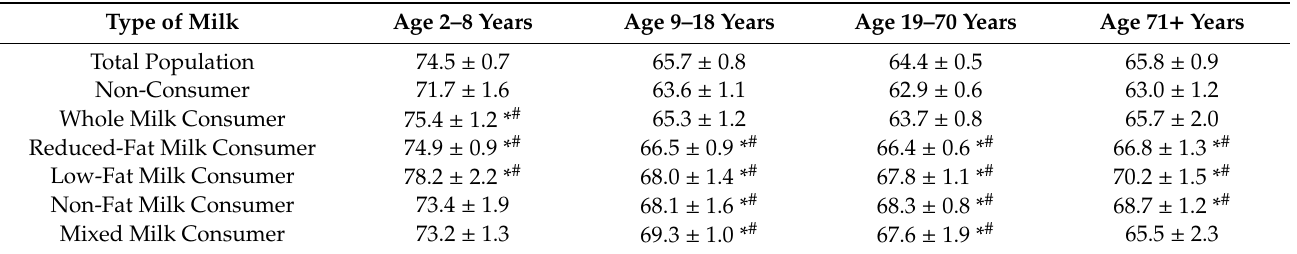
Table 5. Serum vitamin D (serum 25(OH)D) status (nmol / L) by di ff erent types of milk intake in di ff erent age groups, NHANES